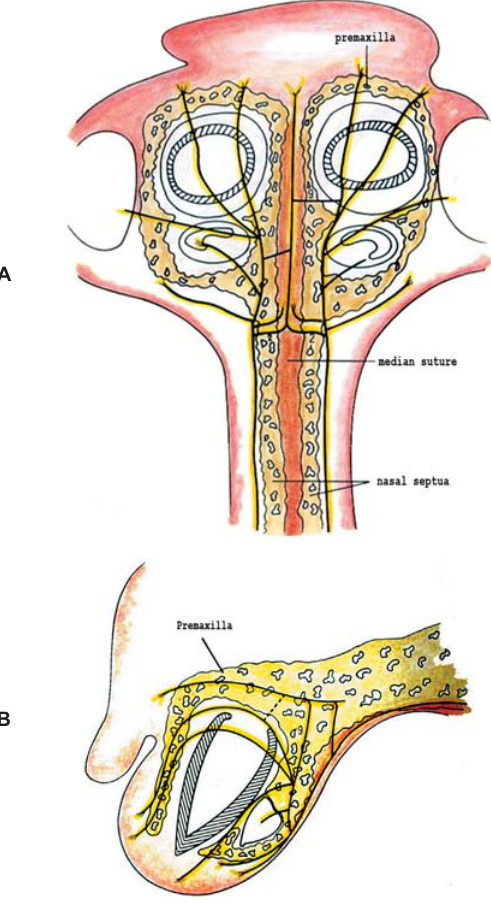
Figure 4- Diagram of nerves and vessels of a bilateral cleft lip and palate. 4A: axial view; 4B: sagittal